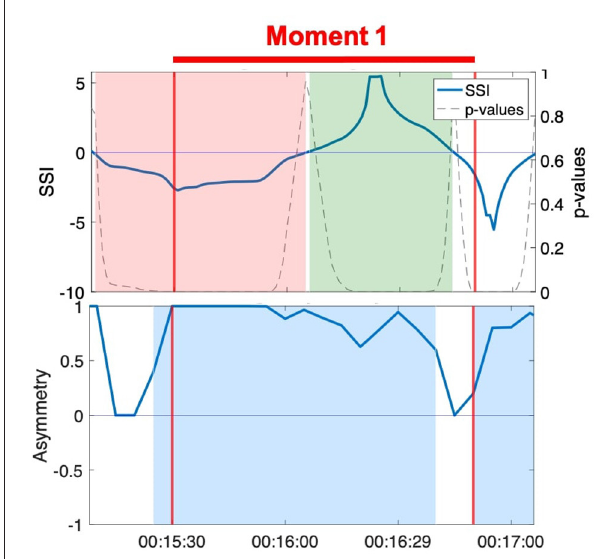
FIGURE 6 | SSI and NSTE asymmetry during Moment 1: Hector and Jean during the resistance sitting activity.